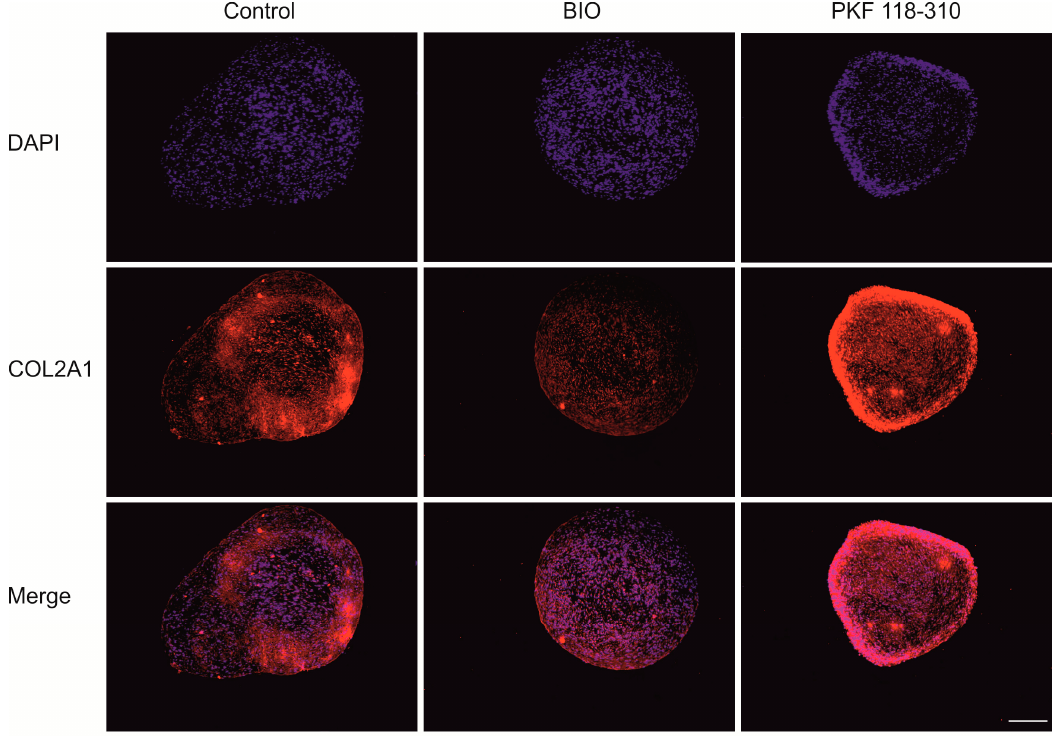
Figure 4. Activation of canonical WNT signaling prevents collagen type 2 production, while inhibition of canonical WNT signaling enhances collagen type 2 production. The expression of type II collagen was visualized by immunofluorescence in midsagittal paraffin sections. The Alexa ® Fluor 546-labelled second antibody was used to detect the positive type II collagen expression. The nucleus was counterstained by DAPI. Scale bar = 500 µm.